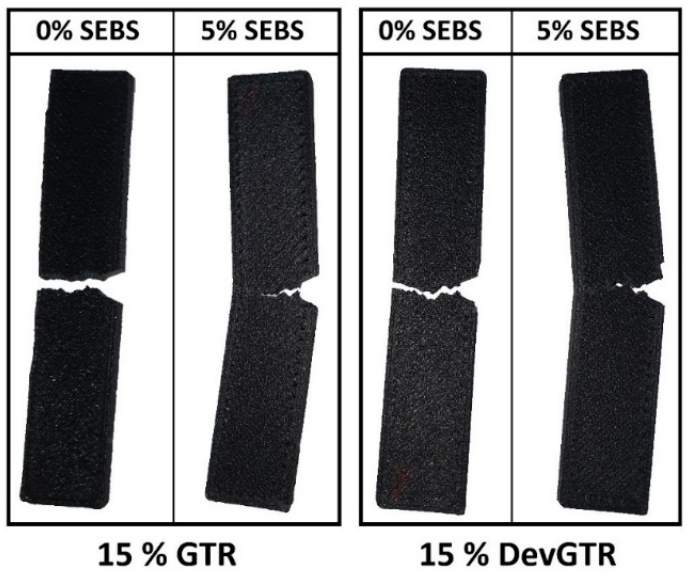
Figure 6. Images of ABS impact specimens (after test), containing 15 wt.% GTR or DevGTR, with and without the incorporation of SEBS (5 wt.%).